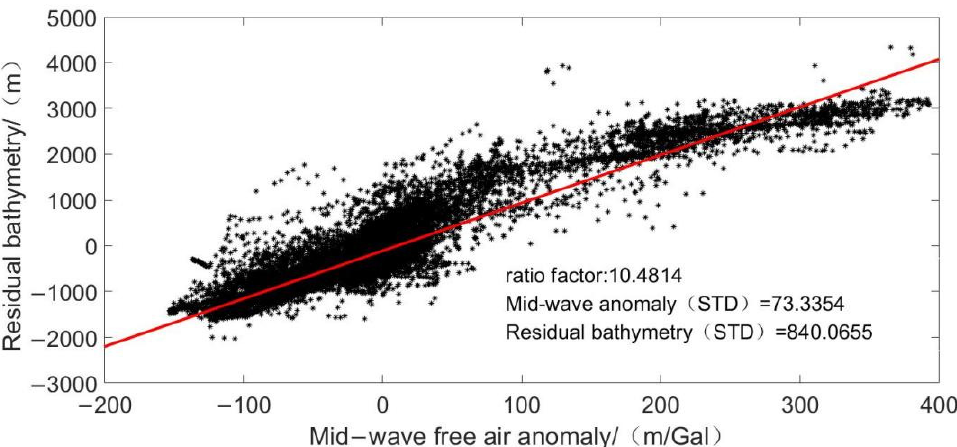
Figure 2. Linear regression results of residual sea depth and gravity anomaly in middle wave section at ship measuring point.